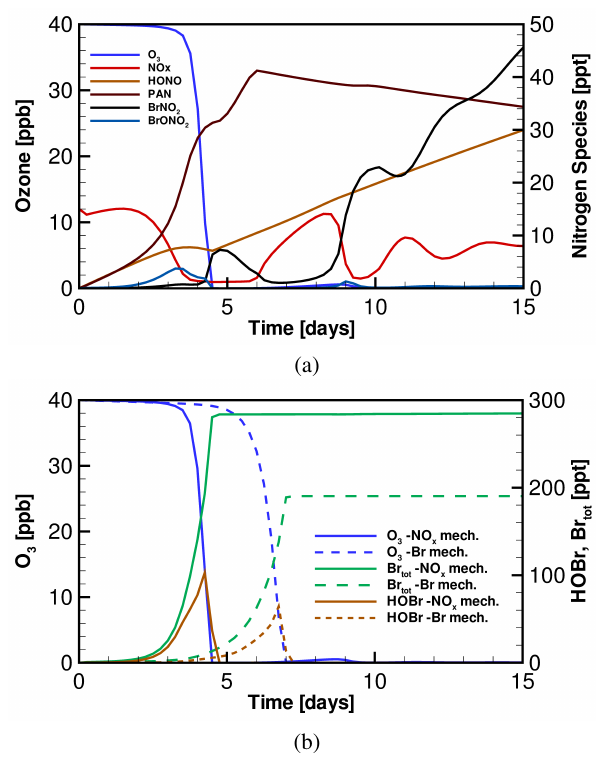
Fig. 9. Time evolution of the mixing ratios of ozone, nitrogen- containing species and bromine for a boundary layer height of 200m. Table 4. List of important NO x -relevant reactions (type F: NO x